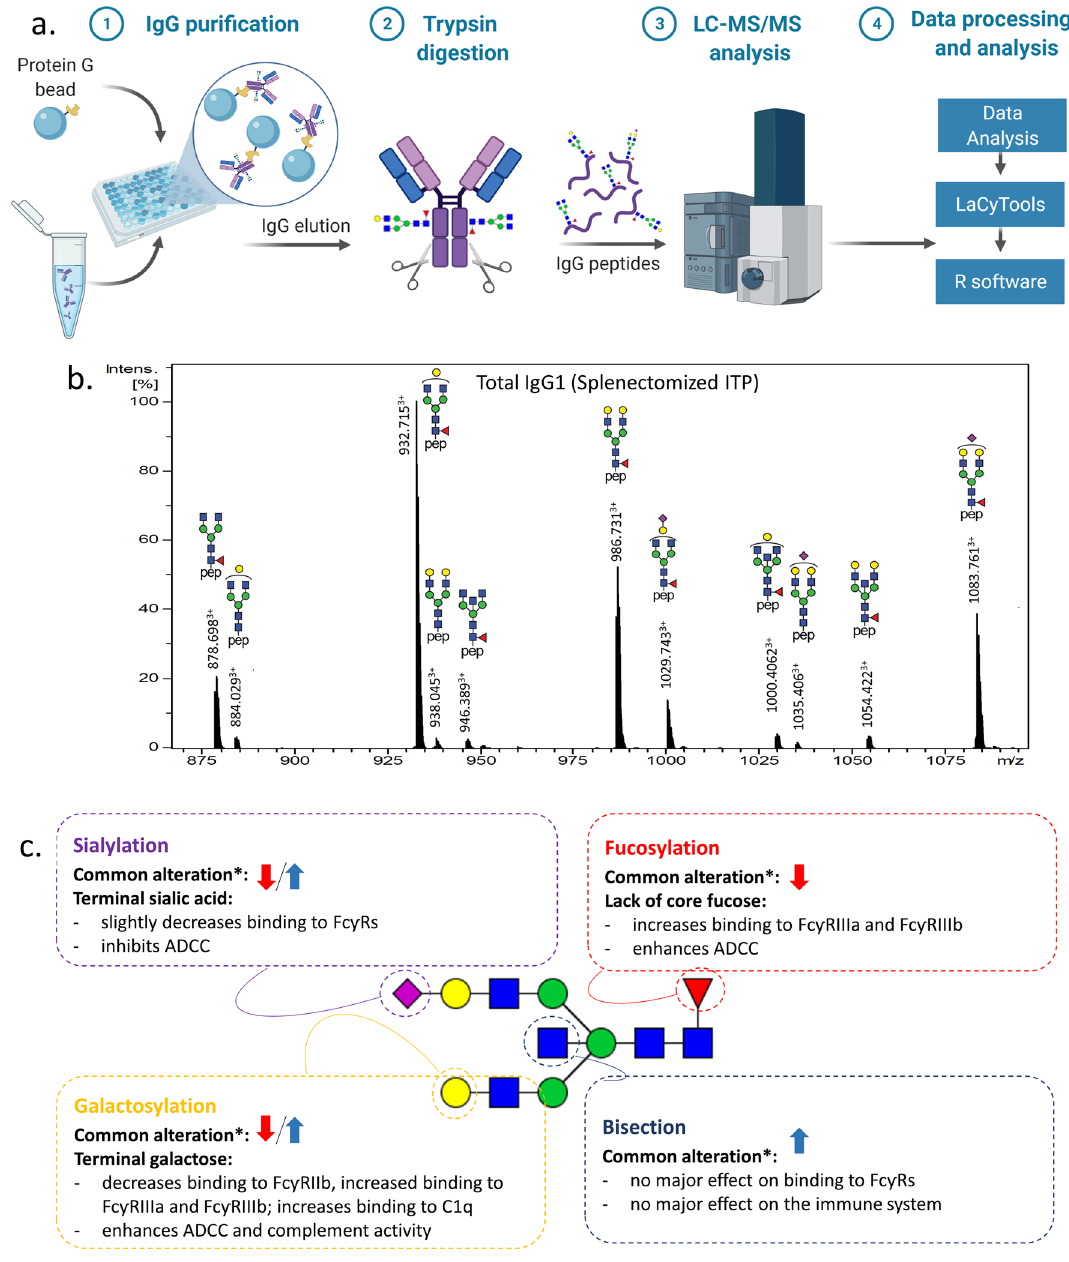
Figure 1. LC–MS analysis of IgG-Fc glycopeptides. ( A ) Schematic workflow. The figure was created with BioRender.com ( B ) Representative LC–MS summed mass spectrum of IgG1 tryptic glycopeptides obtained from a 43 year-old splenectomized ITP male. Annotated are the 11 most abundant IgG1 glycopeptides. Green circle: mannose, yellow circle: galactose, blue square: N-acetylglucosamine, red triangle: fucose, pink diamond: N-acetylneuraminic acid. ( C ) Scheme of the IgG-Fc glycan structure, common disease-related changes in total IgG and their immunological implications. It shows derived glycosylation traits representing common glycosylation features shared by glycan composition: sialylation—sialylation per antenna of biantennary glycans, fucosylation—fraction of fucosylated glycans, galactosylation—galactosylation per antenna of biantennary glycans, bisection—fraction of glycans with bisecting N-acetylhexosamine. For detailed calculation per IgG subclass see Supplementary Table S2. *Down arrow refers to a commonly observed lower and up arrow to higher proportion of the corresponding IgG glycosylation trait in patients suffering from autoimmunological, infectious and inflammatory diseases compared to healthy controls; ADCC—antibody-depended cellular cytotoxicity